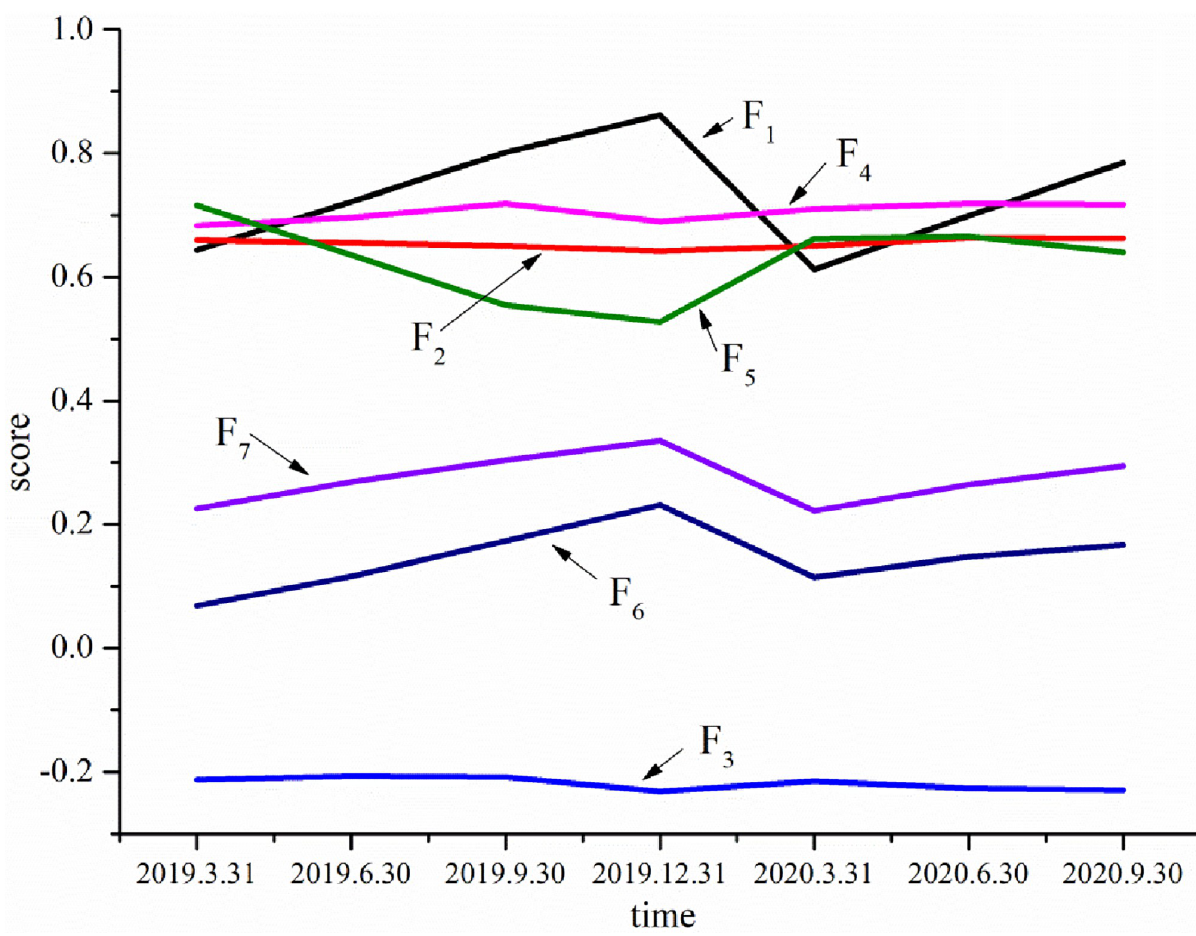
Fig 2. The quarterly average score of common